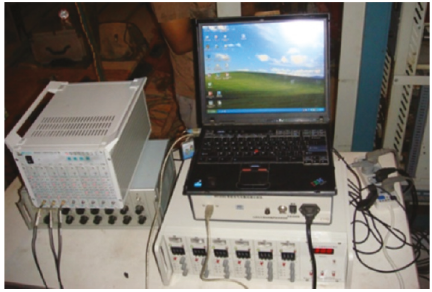
Figure 5: Dynamic response acquisition system.